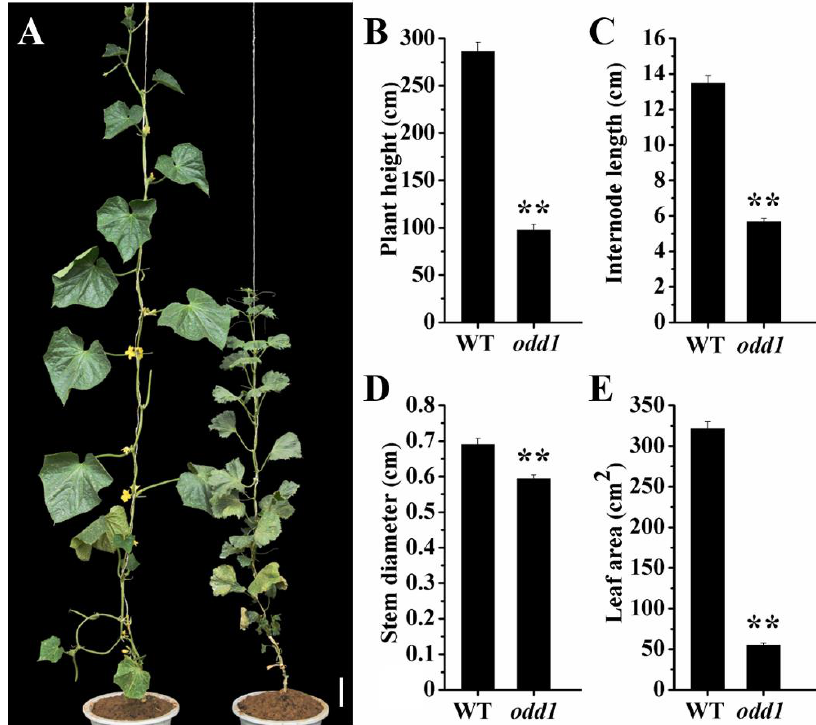
Figure 1. Phenotypic comparison between the WT and odd1 mutant. ( A ) Adult plants of WT (left) and odd1 (right), respectively. ( B ) Plant height. ( C ) Internode length. ( D ) Stem diameter. ( E ) Leaf area of WT and odd1 at fruit setting stage. Scale bar represents 10 cm. ‘**’ indicates very significant differences at p = 0.01 level. Vertical bars represent standard deviation (n = 15).